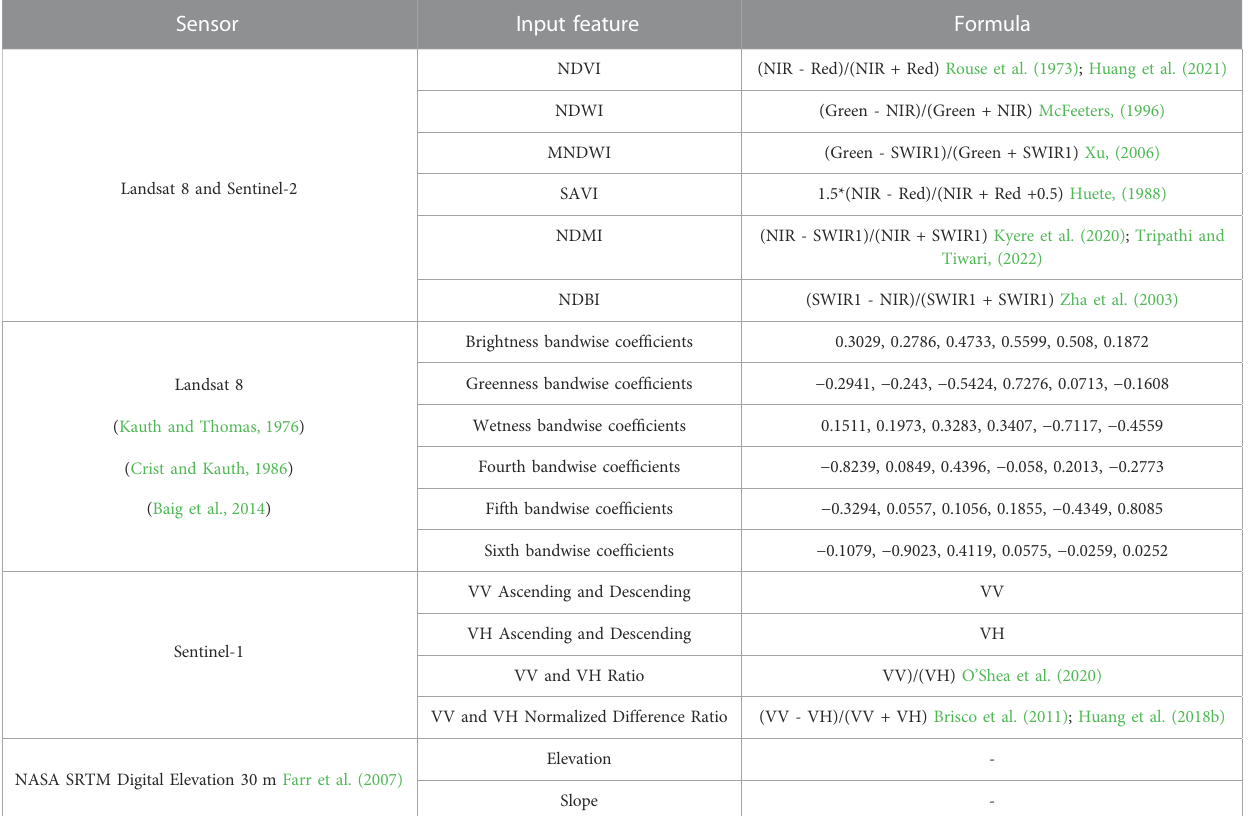
TABLE 1 Set of 28 EO derived features used for model inputs in the ACES